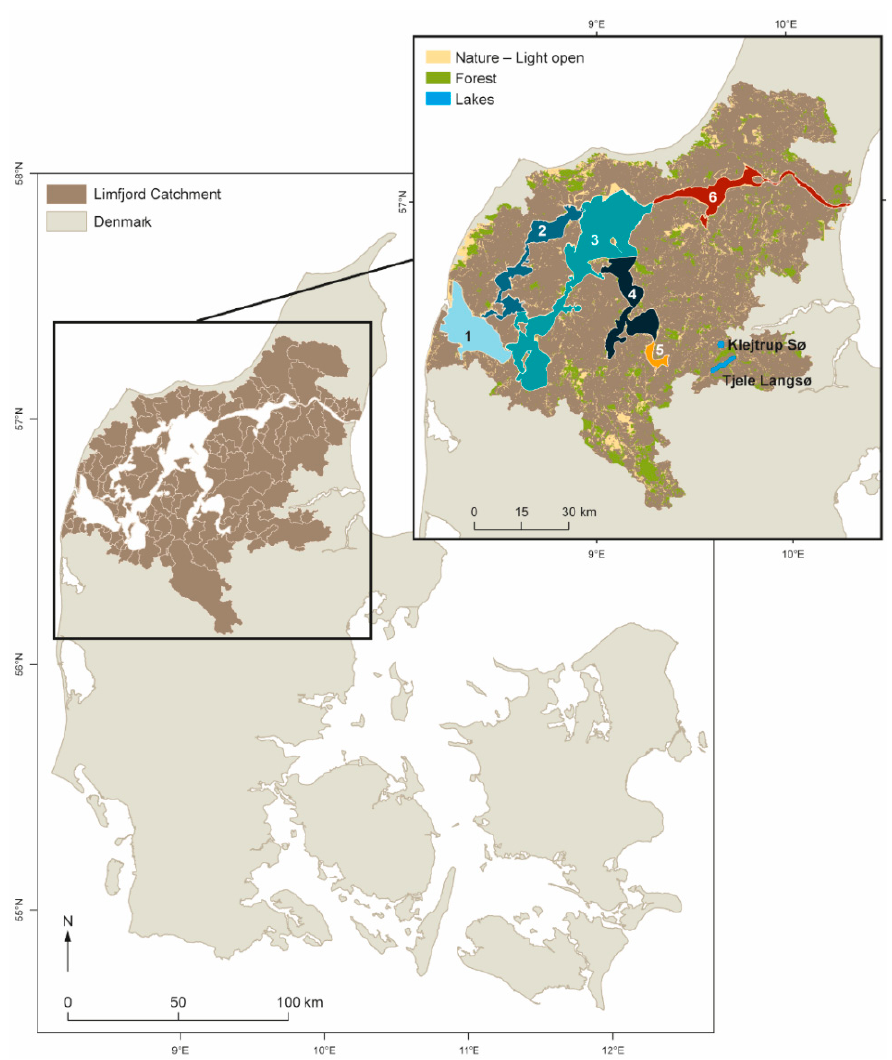
Figure 2. A map of Denmark and the location of the Limfjord with its catchment area divided into 118 sub-basins constituting the study area. The catchment area contains the two lakes Klejstrup and Tjele Langsø, as well as large terrestrial nature areas. The zoom to the right shows the six marine areas of the Limfjord in different colors: 1. Nissum Bredning, 2. Thisted Bredning, 3. Løgstør Bredning, 4. Skive Fjord–Lovns bredning–Riisgårde Bredning, 5. Hjarbæk Fjord and 6. Nibe Bred- ning.